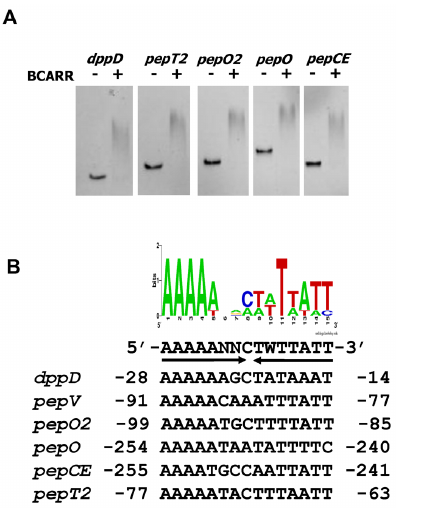
Figure 4. The search for a consensus motif for BCARR binding. Electrophoresis mobility shift assays with the promoter regions of proteolysis genes using the purified BCARR protein (A). The upstream regions of the pepT2, pepCE, pepO, pepO2 and dppD genes were incubated alone or with 2.2 m M BCARR protein and 10 mM BCAAs. A conserved motif was identified for these six upstream sequences by MEME analysis [28] (B). The weight matrix shows the frequency of A, C, T, or G nucleotides (as indicated in the legend) at each position of the motif. The inversely repeated consensus sequence (indicated by arrows) deduced from these frequencies is shown below the diagram. W can be either A or T. N can be any nucleotide. A graphical representation of the identified motif was obtained at the Weblogo website (http://weblogo. berkeley.edu/logo.cgi). Nucleotide positions are relative to the start codon of each proteolysis gene or the first gene in each operon ( pepCE and pepO ).